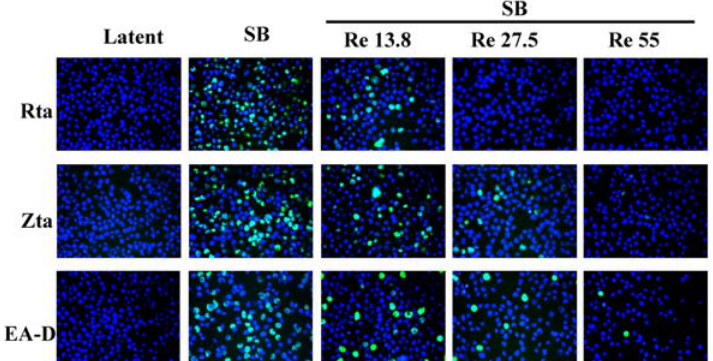
Figure 2. Indriect immunofluorescence analysis of inhibition effects on the expression of EBV lytic